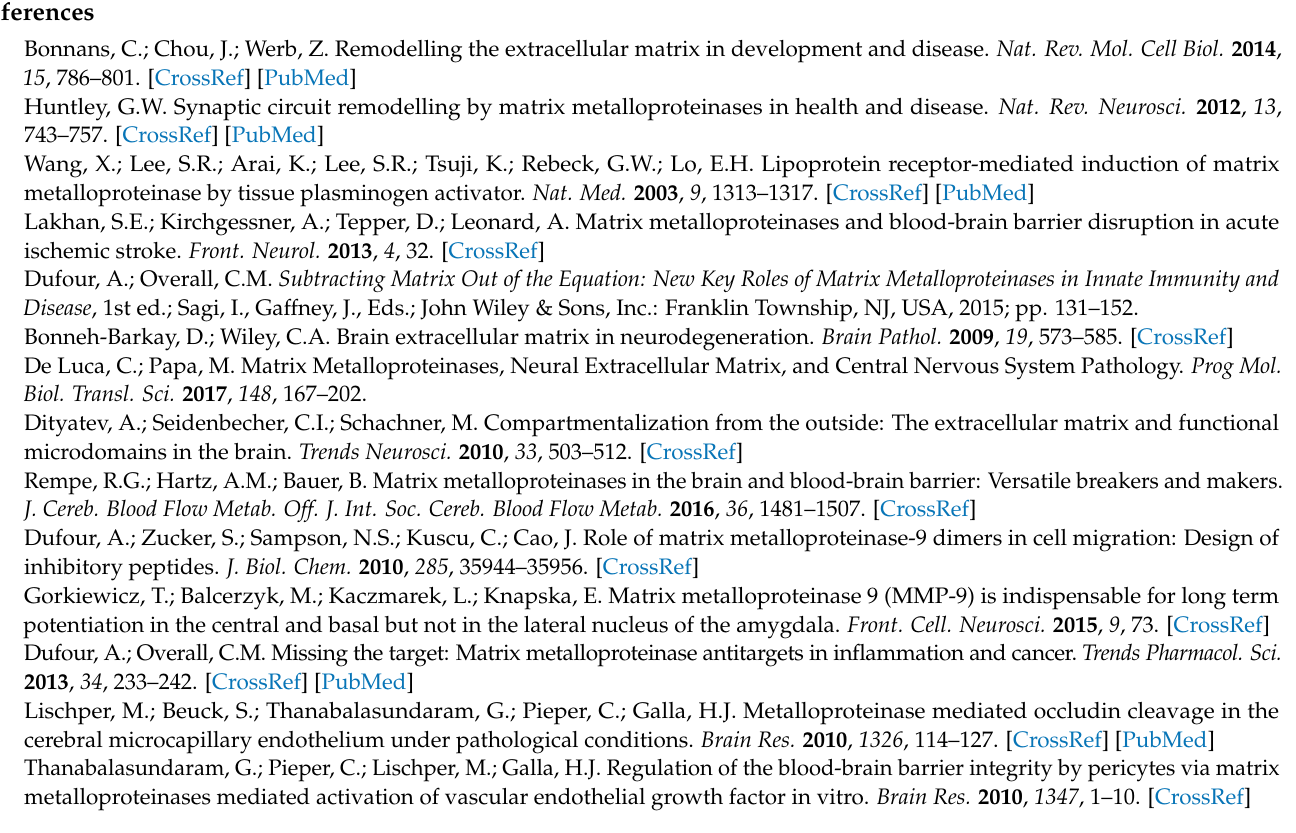
Table S2: Semi-quantification of MMP9 staining in rat hippocampus; Supplementary